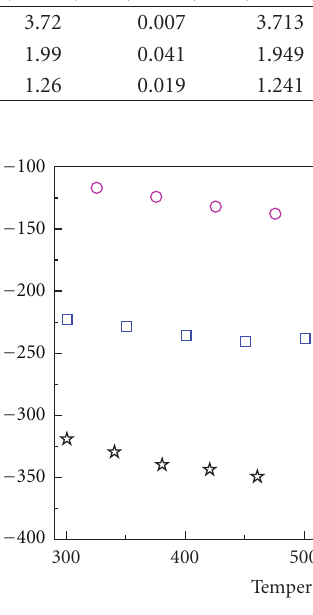
Figure 3: The temperature dependence of the Seebeck coe ffi cient S of the Ca 1 − x Gd x MnO 3 − δ (0.00, 0.02, and 0.05).